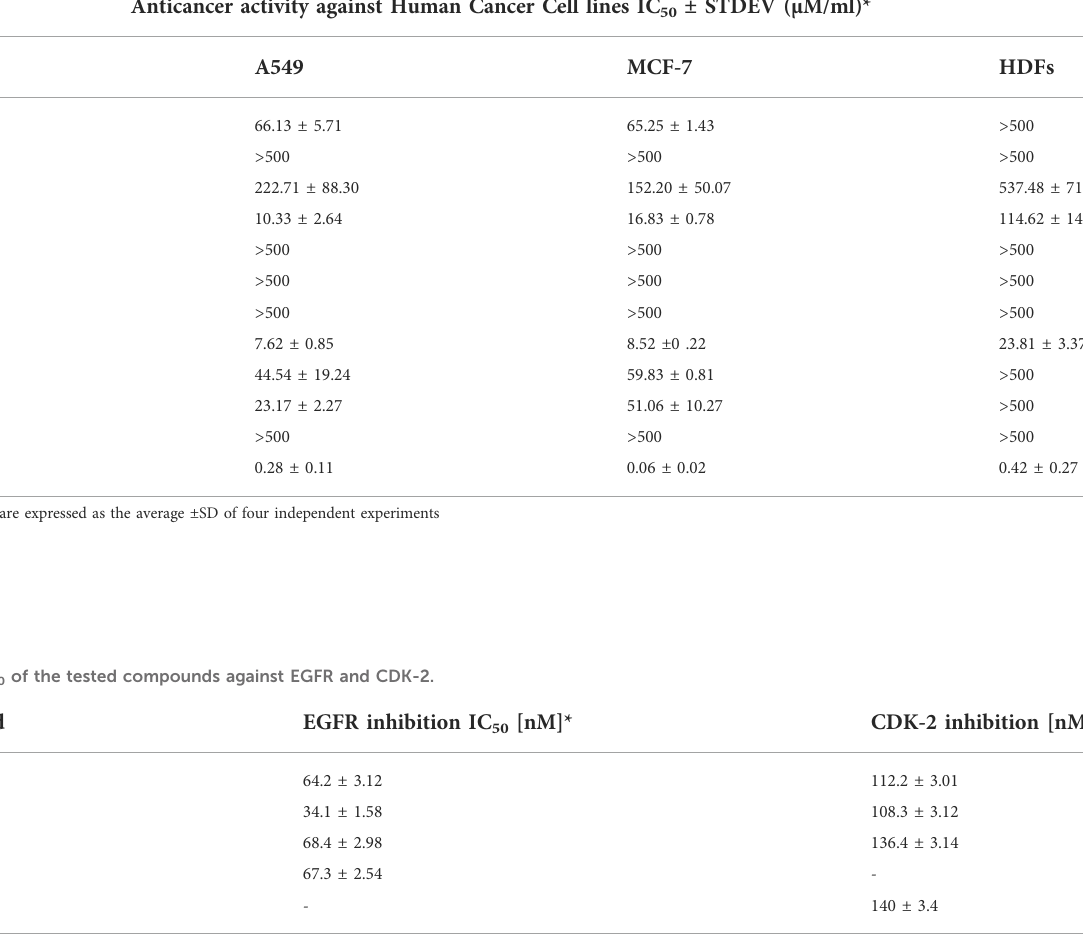
TABLE 2 IC 50 values of the tested compounds 5a-k after the MTT assay showing variable responses of the treated cell lines.